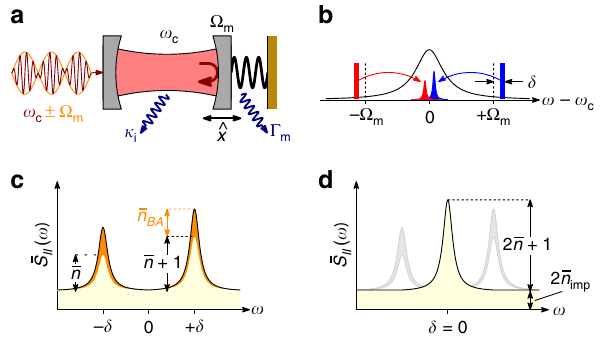
Fig. 1 Backaction-evading measurement. a Illustration of a cavity optomechanical system. Light in a cavity with optical resonance ω c and full linewidth κ (of which κ i are intrinsic losses) is coupled to the position ^ x of a mechanical oscillator that has frequency Ω m and linewidth Γ m . In a backaction-evading (BAE) measurement, the probe is amplitude-modulated at the mechanical frequency Ω m , coupling to the quadrature ^ X . b Frequency space con fi guration slightly detuned from BAE measurement, where the probe is modulated at Ω m + δ . c Resulting power spectral density of the cavity output fi eld for an oscillator in a thermal state (mean occupation (cid:2) n ), showing the asymmetric Stokes and anti-Stokes scattered sidebands, plus the heating due to QBA. d When tuning to the BAE scheme δ = 0, the two sidebands coalesce and the QBA is cancelled, see Eq. (1). The